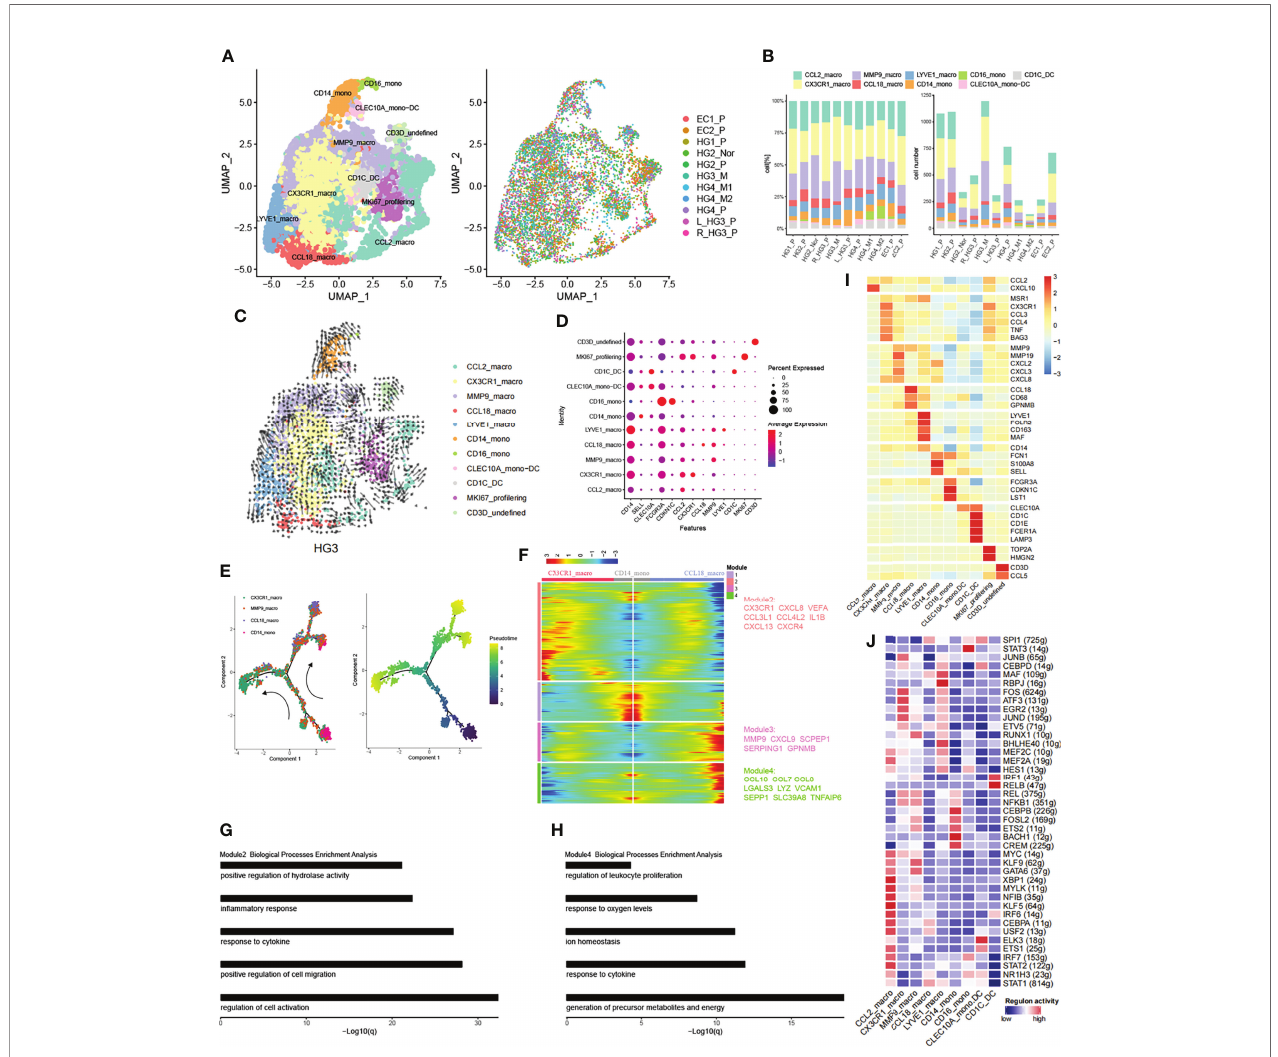
FIGURE 6 | Subpopulations of myeloid cells in HG_M. (A) The UMAP projection of 7265 myeloid cells of 11 samples from six patients (indicated by labels and colors). (B) Proportion and cell number of each myeloid subtype in 11 samples. (C) RNA velocity of each myeloid subtype. (D) The dot plot displays canonical cell markers. (E) Trajectory reconstruction of monocyte evolved into macrophages. (F) Dynamics gene expression pro fi le during monocyte-to-macrophage terminal differentiation. (G , H) Biological processes enrichment analysis of module 2 and module 4. (I) Heatmap of signi fi cant genes in each subtype. (J) Activate regulons in each myeloid